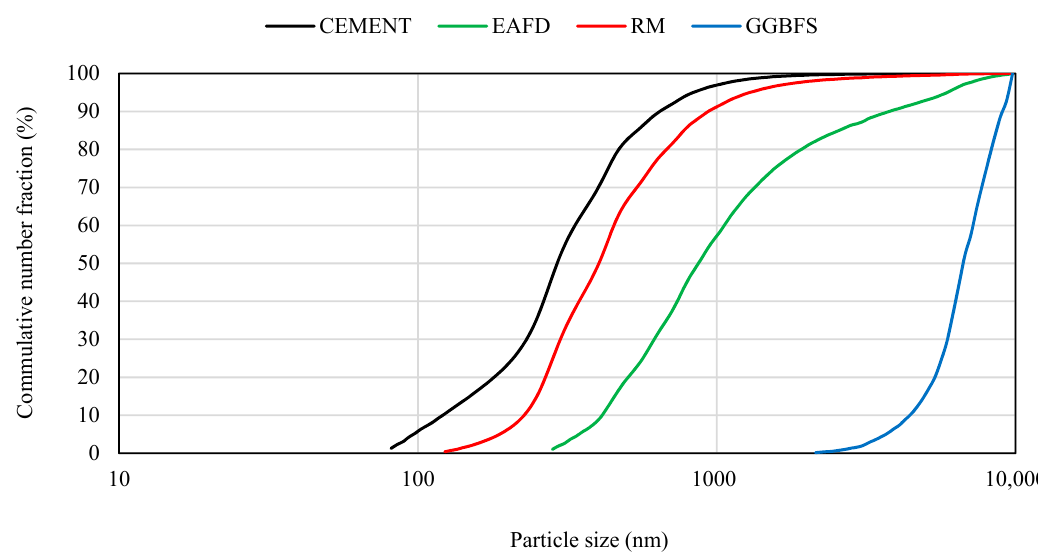
Figure 2. Particle size distribution of RM, GGBFS, and EAFD.